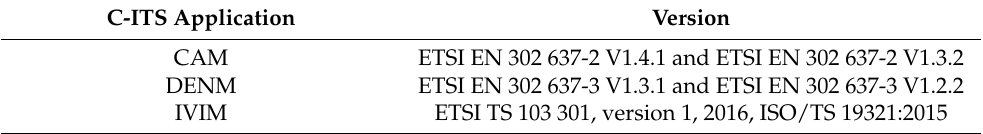
Table 2. Supported Cooperative Intelligent Transport Systems (C-ITS) application